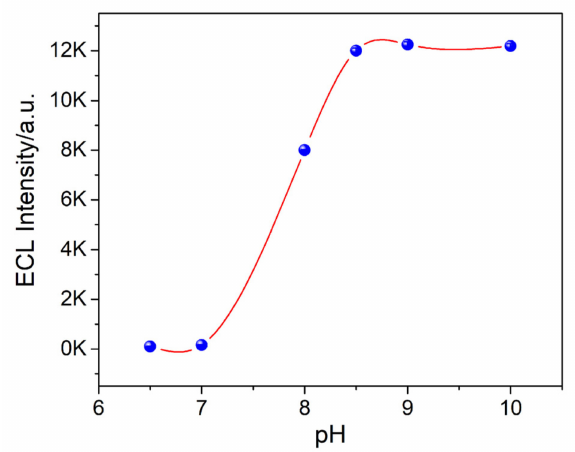
Figure 4. Effect of pH on ECL intensity of Ru(bpy) 32+ /AZA system in 0.1 M PBS; 1.0 mM AZA and 0.5 mM Ru(bpy) 32+ were used in this study.